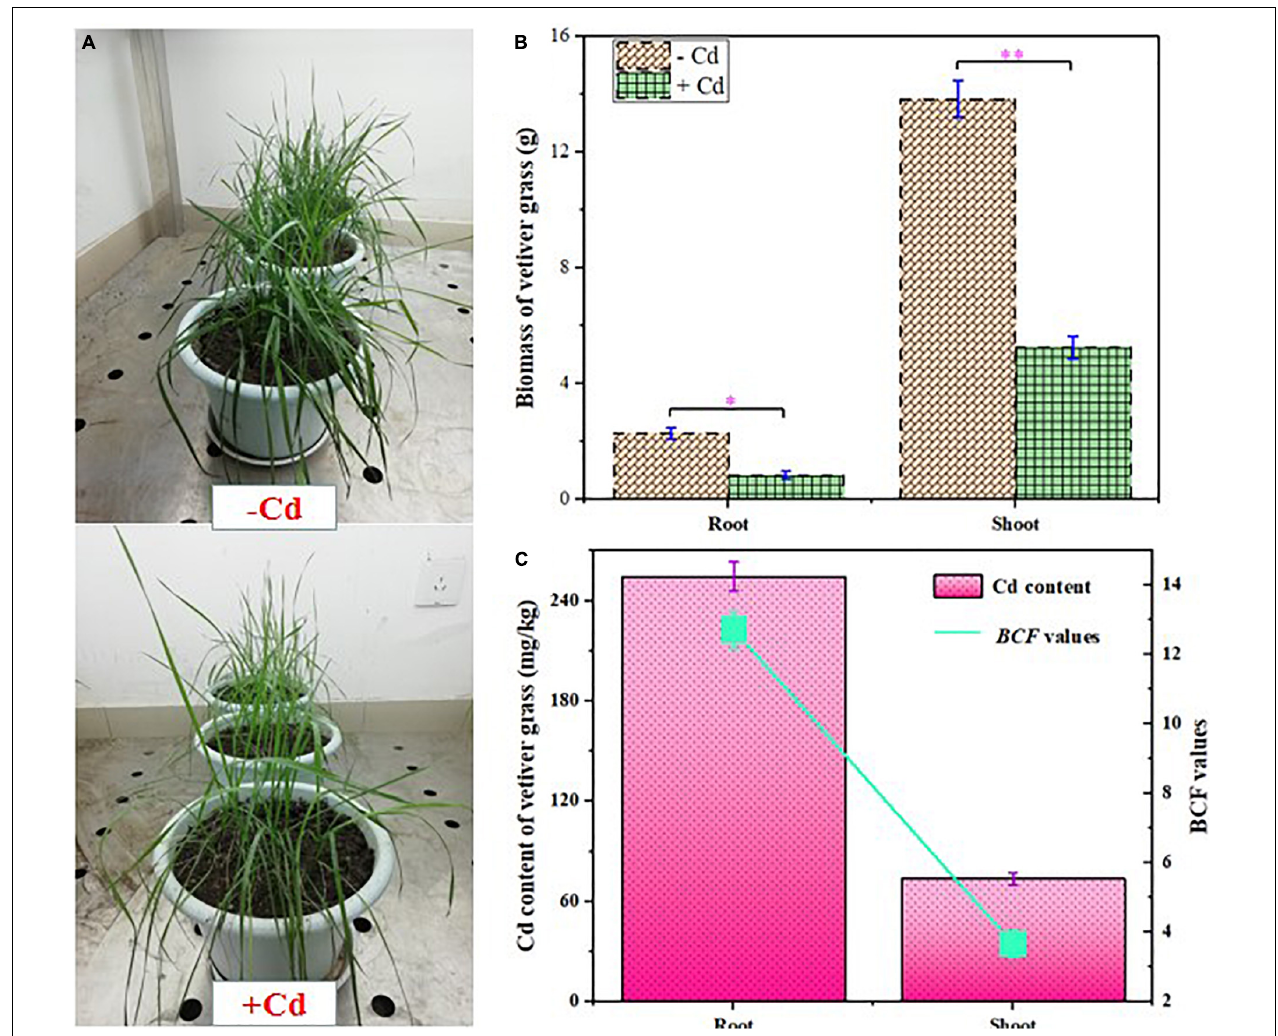
FIGURE 1 | Growth response (A) , biomass (B) , and cadmium (Cd) content and bioaccumulation factor (BCF) values (C) of Chrysopogon zizanioides . Error bars represent SD values ( n = 3). * and ** represent p < 0.05 and p < 0.01,